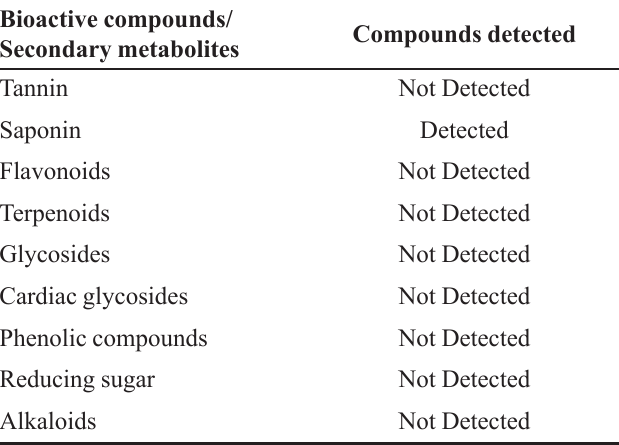
TABLE V - Qualitative phytochemical analysis of DP1 Bioactive